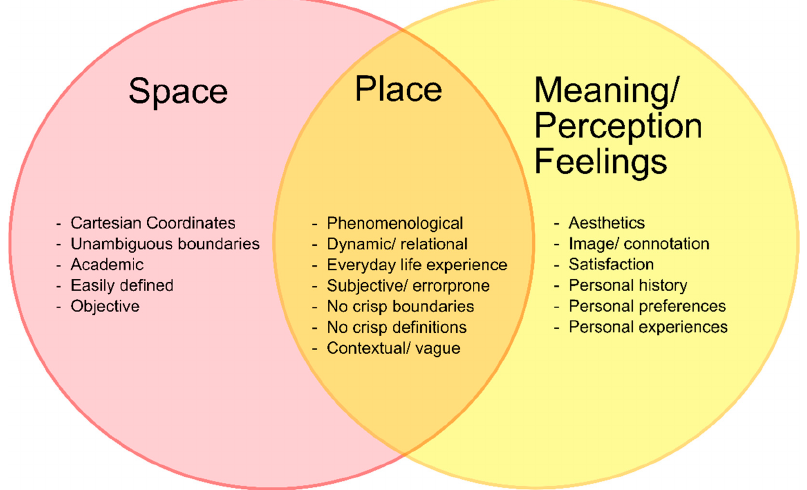
Figure 1. The notion of place in relation to space and perception.